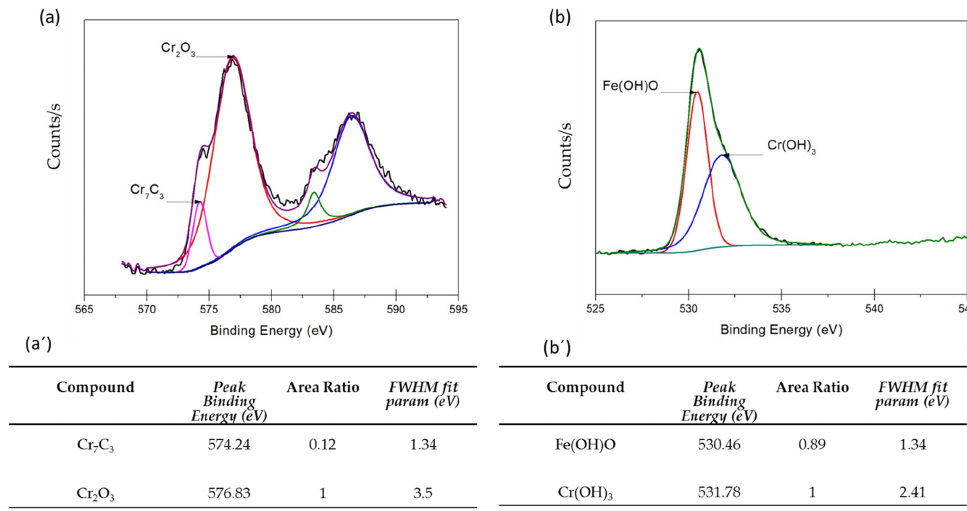
Figure 6. X-ray photoelectron spectra for CUSTOM450NA–75 min–70 °C: ( a ) Cr 2p, ( b ) O 1s. Param- eters obtained: peak binding energy and FWHM fit param ( a’ ) Cr 2p, ( b’ ) O 1s.